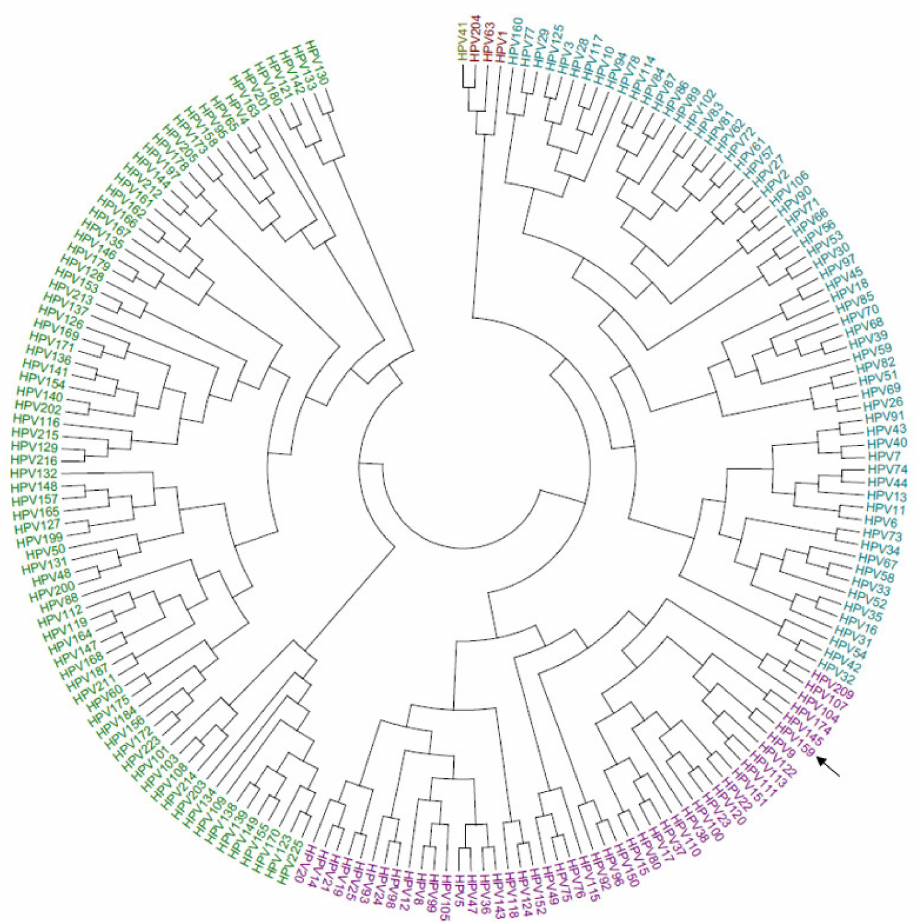
Figure 2. A phylogenetic tree that was obtained from the available nucleotide sequences of the L1 gene of all HPV types (https://pave.niaid.nih.gov/, accessed on 7 July 2021). The black arrow marks HPV159. Alpha -PVs are marked with blue, Beta -PVs with purple, Gamma -PVs with green, Mu -PVs with dark red, and Nu -PVs with